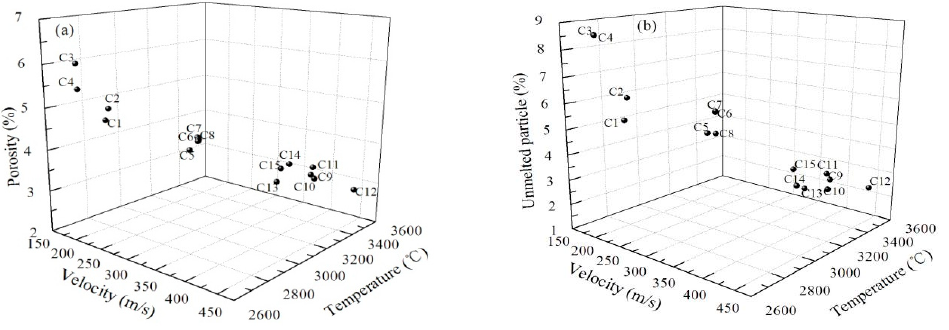
Figure 4. The influence of the temperature and velocity of particles on the porosity ratio and the percentage of unmelted particles: ( a ) Porosity ratio; ( b ) Percentage of unmelted particles.